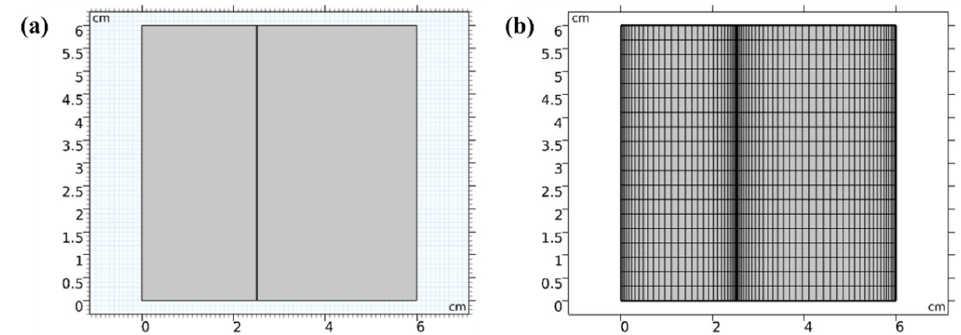
Figure 2. ( a ) Geometry of the CDI device; ( b ) meshes in the device defined in the geometry